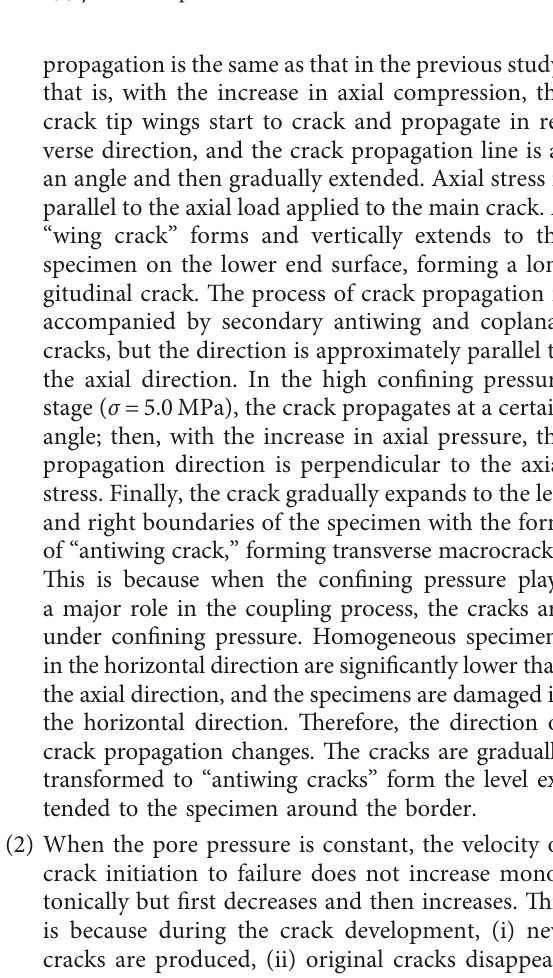
Figure 5: Maximum shear stress (upper) and pore pressure (lower) evolution diagram of different crack angle models. (a) β � 15 ° , step: 11–40; (b) β � 30 ° , step: 10–25; (c) β � 45 ° , step: 10–15; (d) β � 60 ° , step: 14–27; (e) β � 75 ° , step: